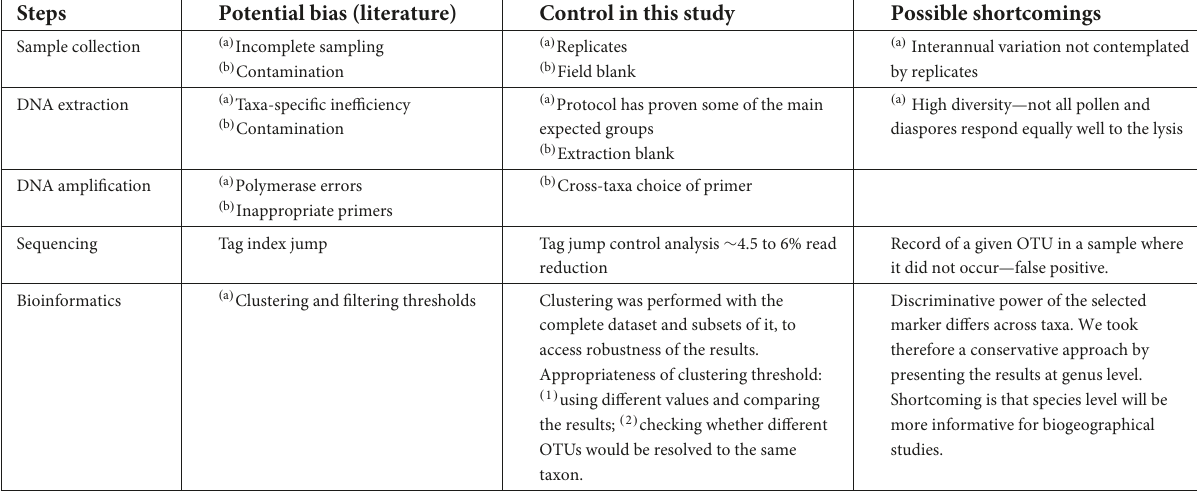
TABLE 1 Best practices summarized for each step of the data generation. Each step (first column) includes its own potential biases as mentioned in the literature (second column), the controls as applied in this study (third column), and the possible shortcomings (fourth column), which are also dealt with in the manuscript discussion section.